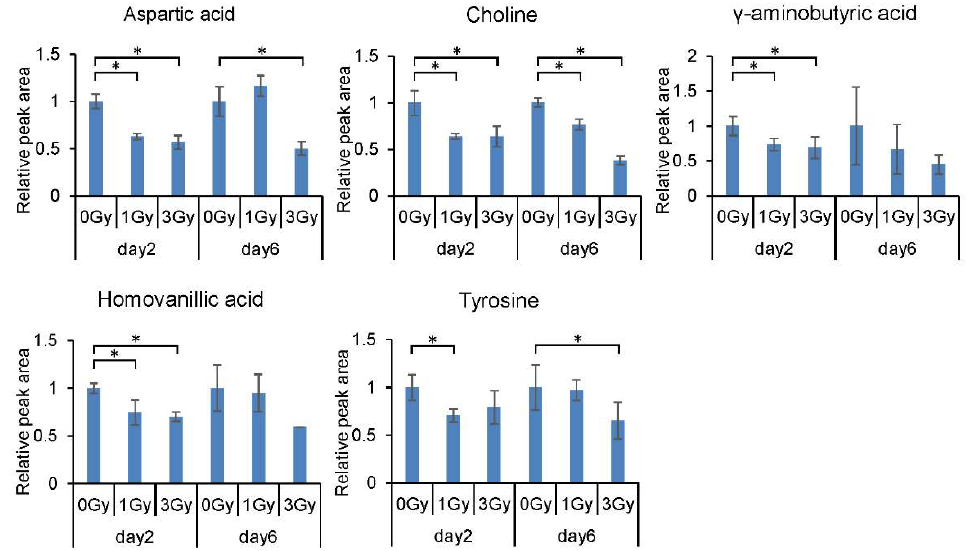
Figure 3. Dose and time response of levels of neurotransmitter-related metabolites in mouse blood cells. All quantitative data are means ± SD. * p < 0.05, Welch’s t -test.